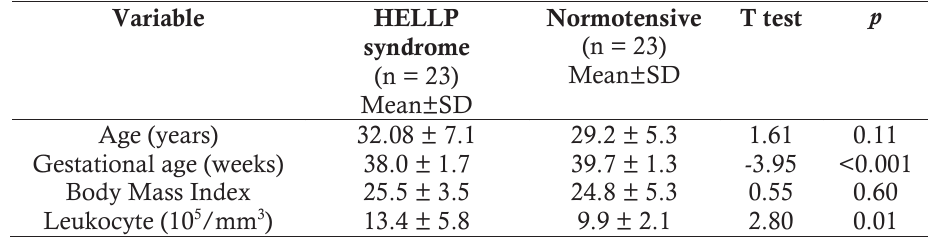
Table 1. Baseline comparisons for HELLP syndrome group to normotensive group.